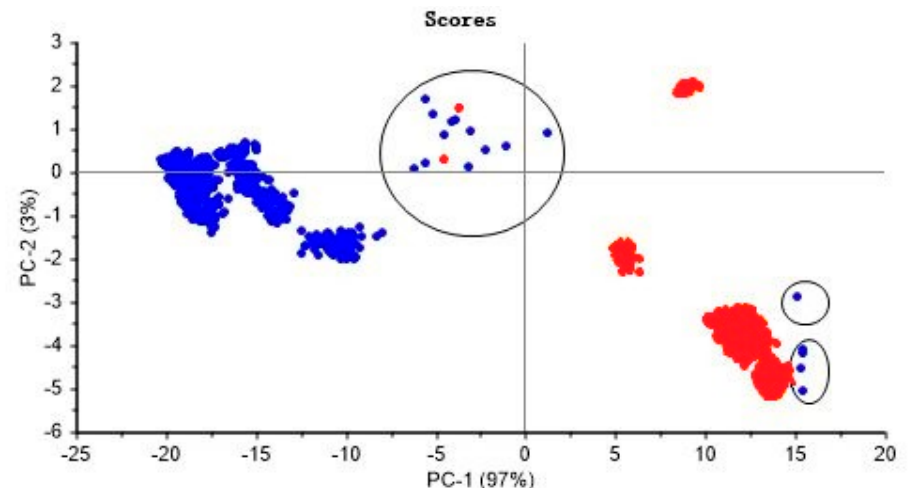
Figure 4. PCA scores and outliers of Zhejiang and non-Zhejiang Ophiopogonis japonicus . Blue represents Zhejiang samples, and red represents non-Zhejiang samples.